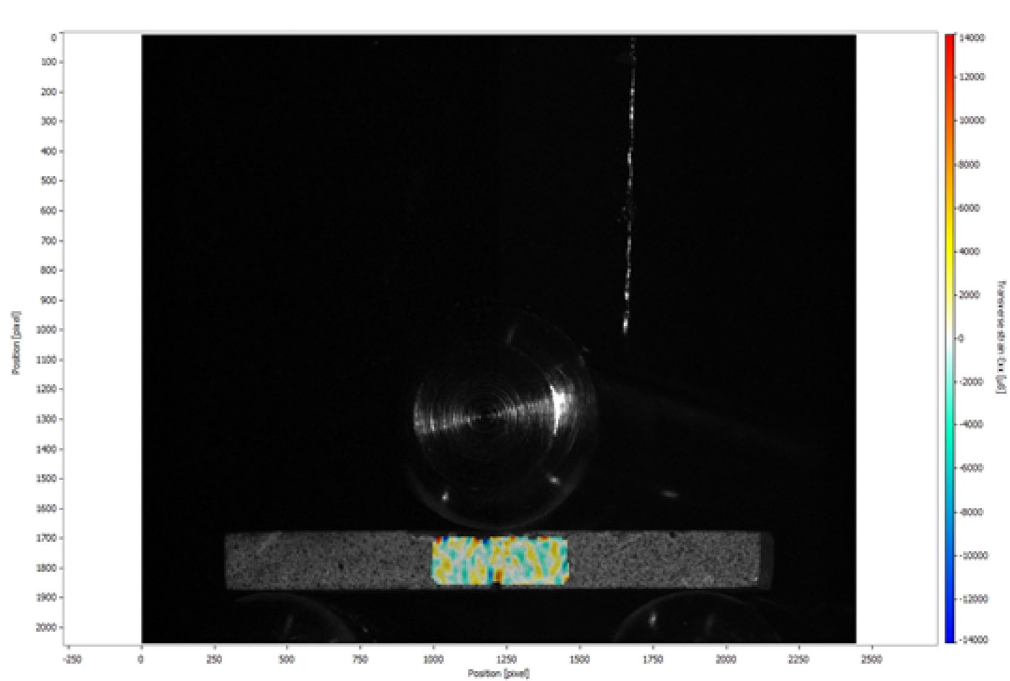
Figure 4. Horizontal strains (Exx) in microstrain (µs) generated during the fracture toughness test of the